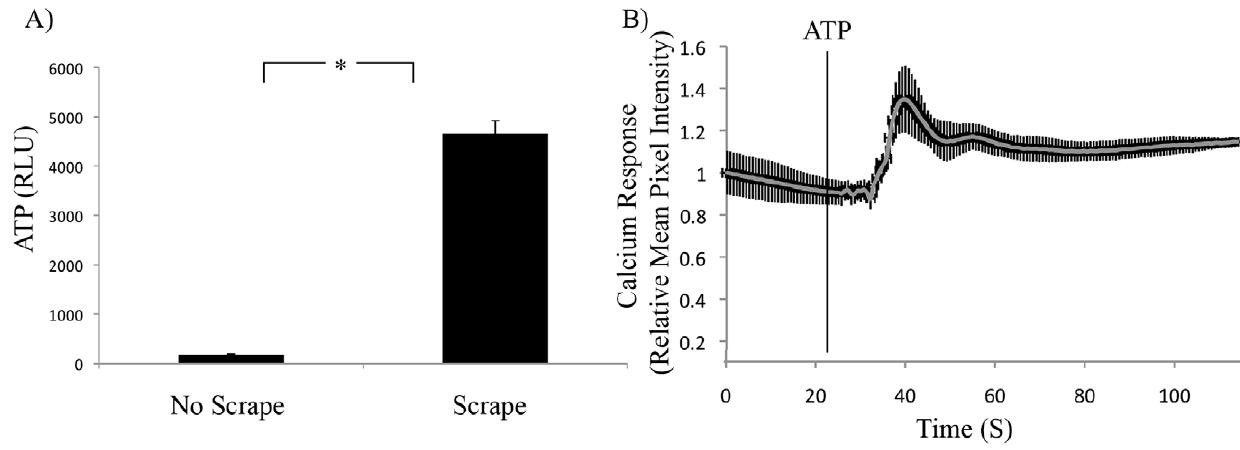
Figure 2. Mechanically Injured Cells Released and Responded to Extracellular ATP. A) Mean ATP content of conditioned media from control or mechanically stimulated A549 monolayers. RLU, relative luciferase units. Error Bars = SD. * = p , 0.05. n=3. B) ATP (50 m M) alone was added to confluent Fluo-4 labeled A549 cells (vertical line). Calcium response was measured by fluorescent microscopy. n=4 movies.